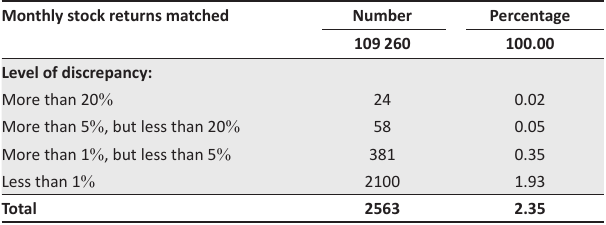
TABLE 1: The comparison of monthly stock returns between the DataGuide and KisValue databases. Monthly stock returns